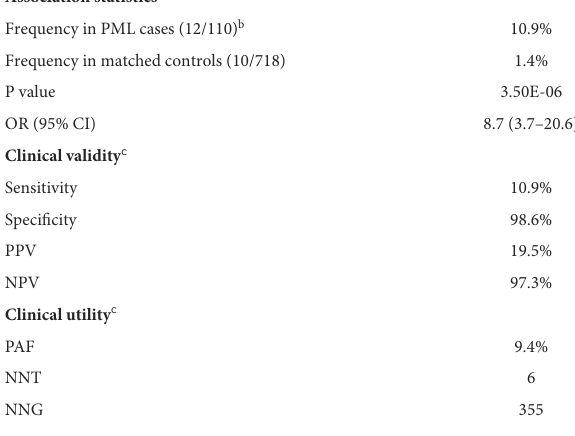
TABLE 5 Clinical validity and utility of a 4-variant PML genetic risk test in drug-exposed cases vs. matched controls. Associationstatistics